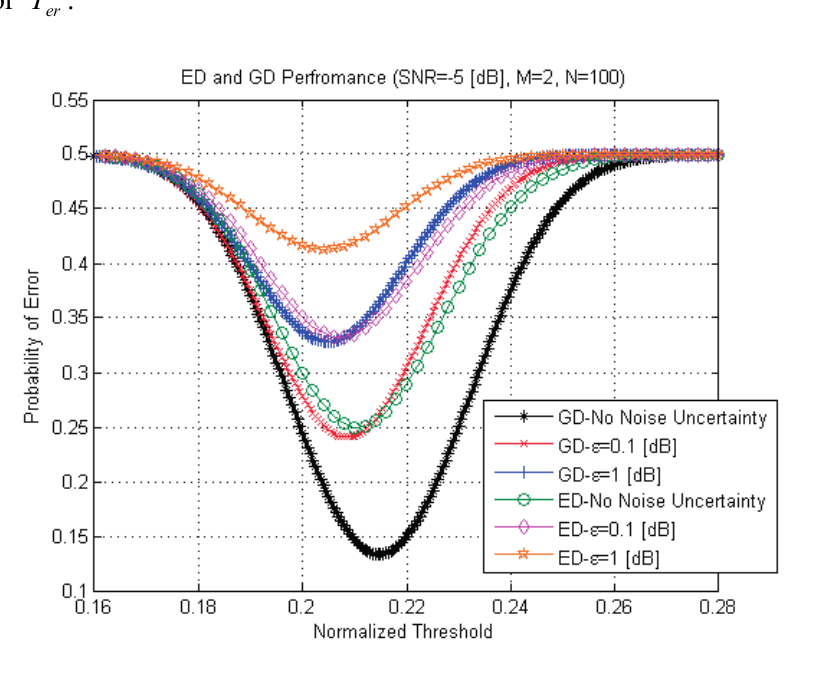
P and ED P as a function of the normalized er er